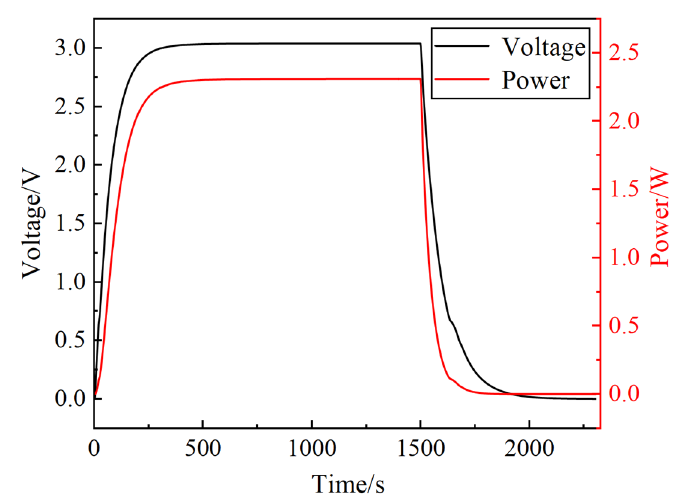
Figure 11. Electrical performance of the TEG